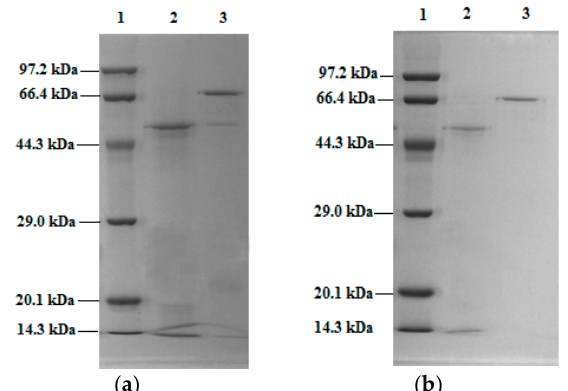
Figure 8. SDS-PAGE electrophoresis spectra of Mal-mPEG5000- β -SPA ( a ) separation by Superdex TM 75 for the first time; Lane 1: marker proteins; Lane 2: SPA; Lane 3: Mal-mPEG5000-SPA by Superdex TM 75. ( b ) separation by Superdex TM 75 for the second time; Lane 1: marker proteins; Lane 2: SPA; Lane 3: Mal-mPEG5000-SPA by Superdex TM 75.